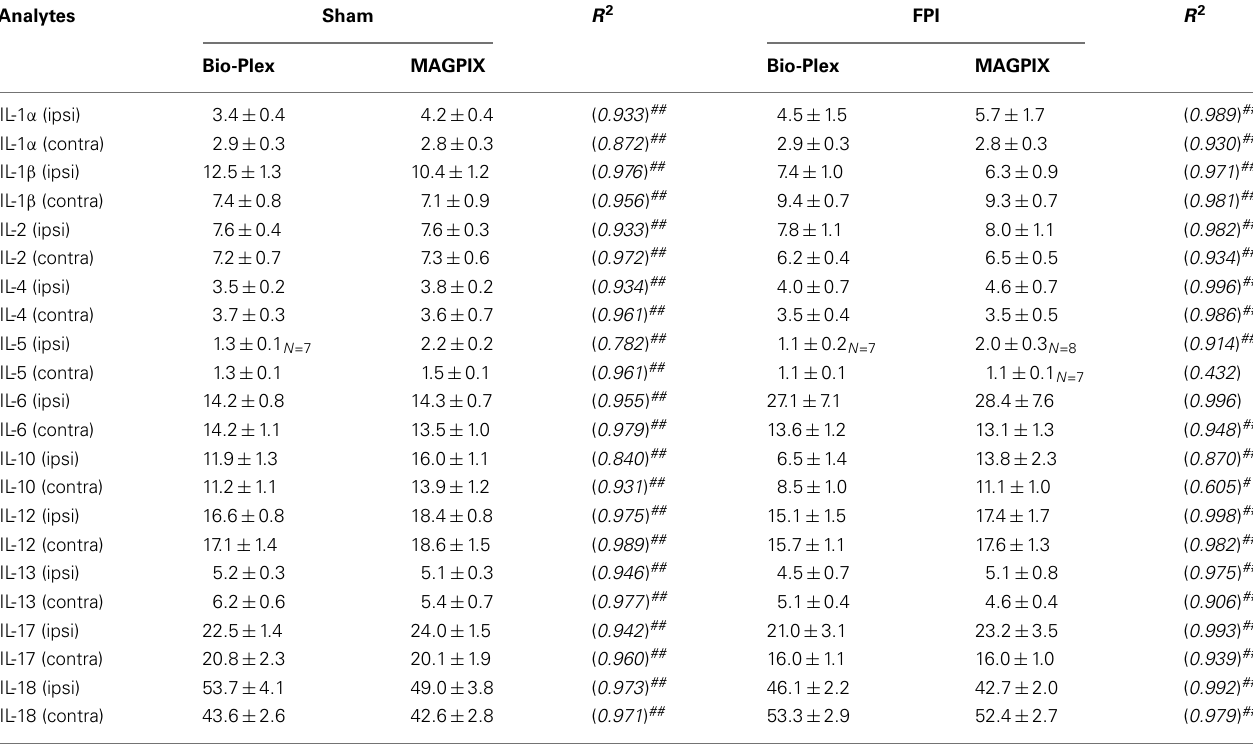
Table 2 | Comparison of the level of analytes in the cortex detected by Bio-Plex vs. MAGPIX 24h after FPI. Analytes